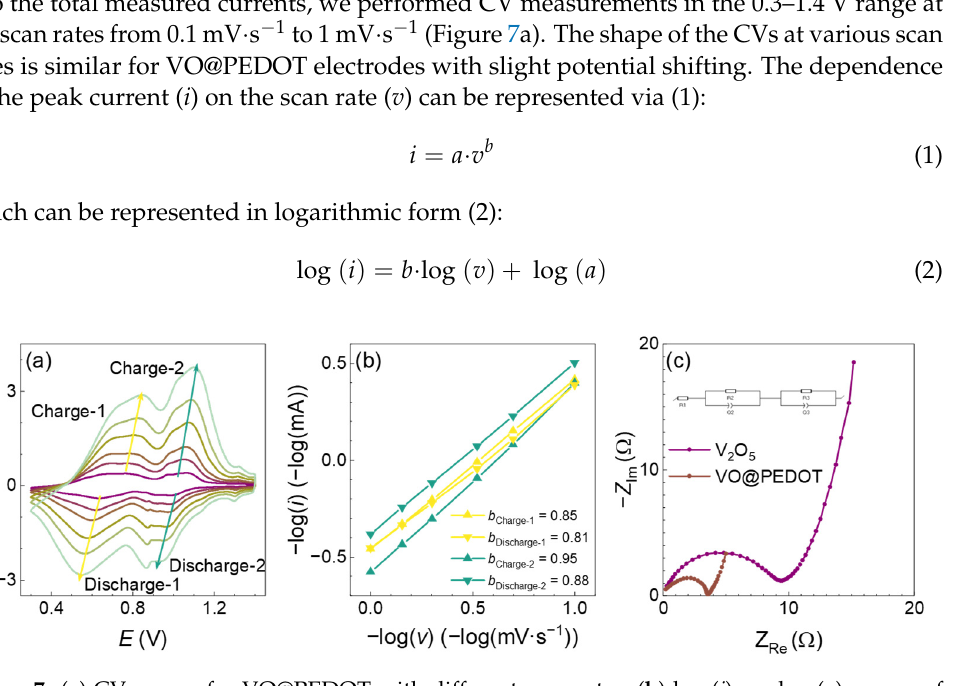
Figure 7. ( a ) CV curves for VO@PEDOT with different scan rates; ( b ) log ( i ) vs. log ( v ) curves of cathodic and anodic peaks of CV curves; ( c ) EIS spectra of the initial V 2 O 5 and VO@PEDOT in 10 kHz to 100 mHz range at 1.4 V.